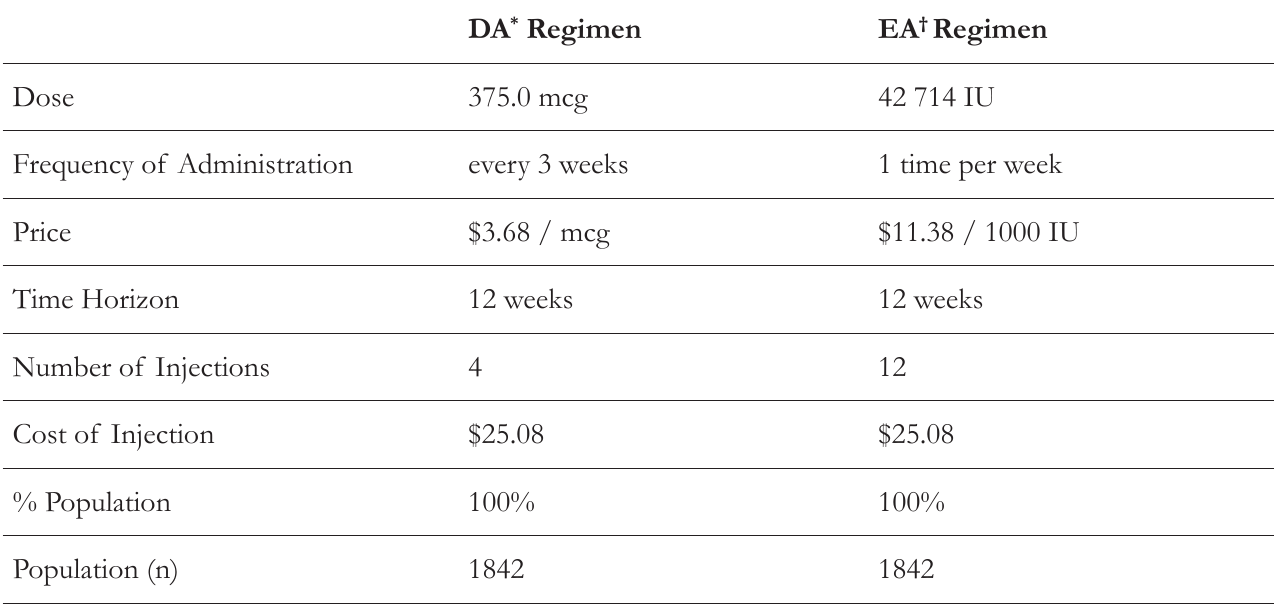
Table 2. Budget Impact Model